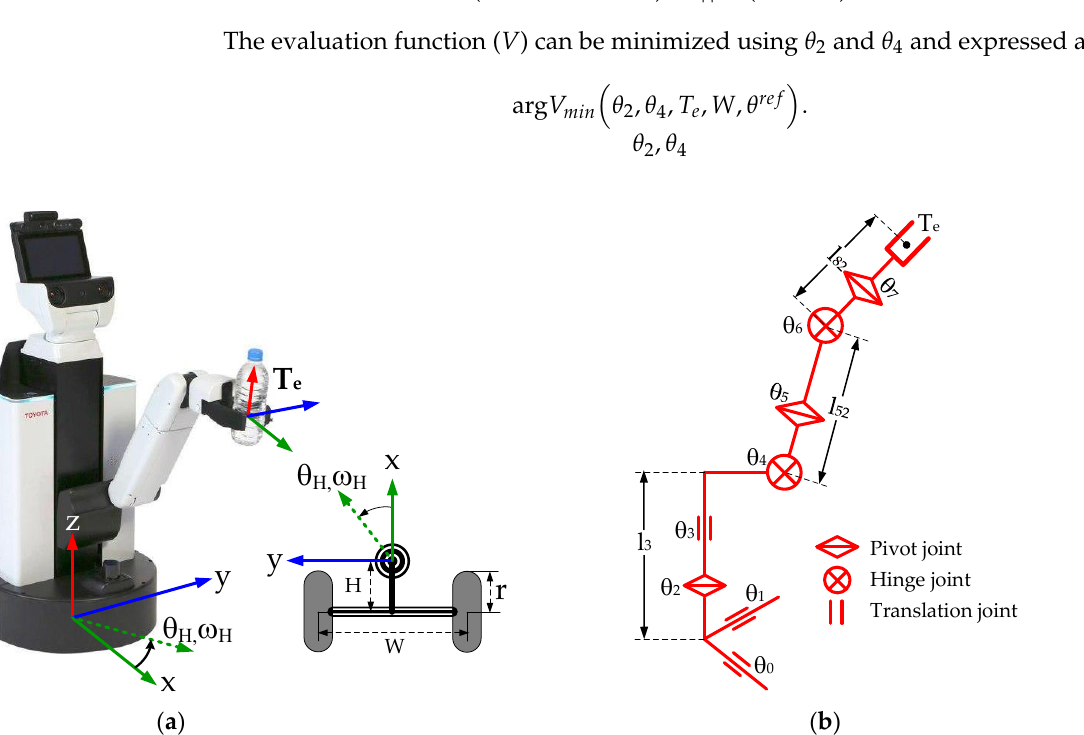
Figure 3. ( a ) The dual-wheel caster-drive robot base and ( b ) the robot join configuration.